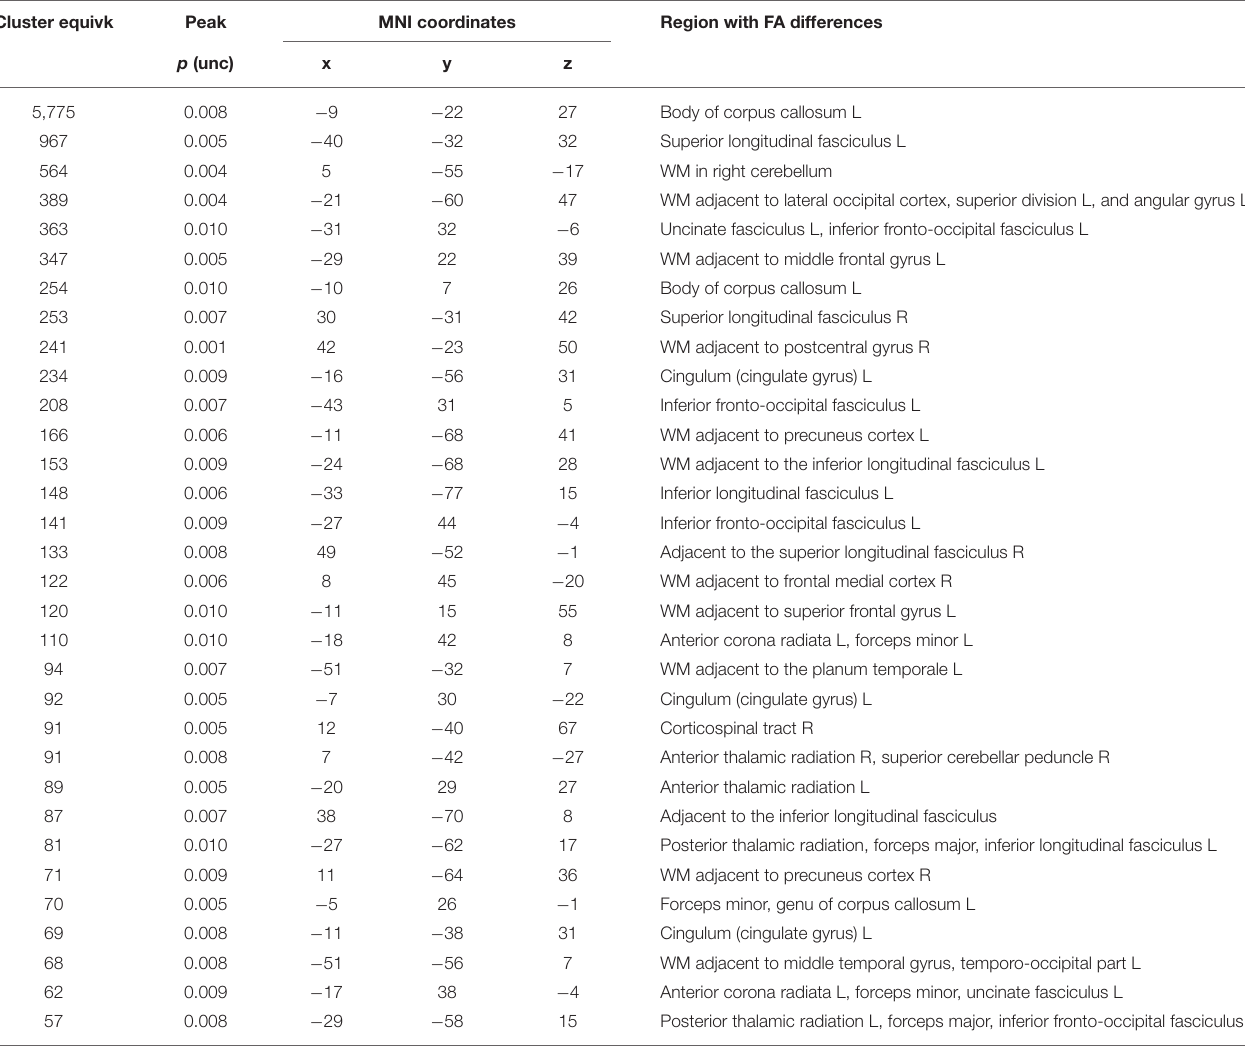
TABLE 6 | Regional brain differences in structural connectivity as measured by FA between HC and EO-OABD patients at p < 0.01, corrected for multiple comparisons. Cluster equivk Peak MNI coordinates Region with FA